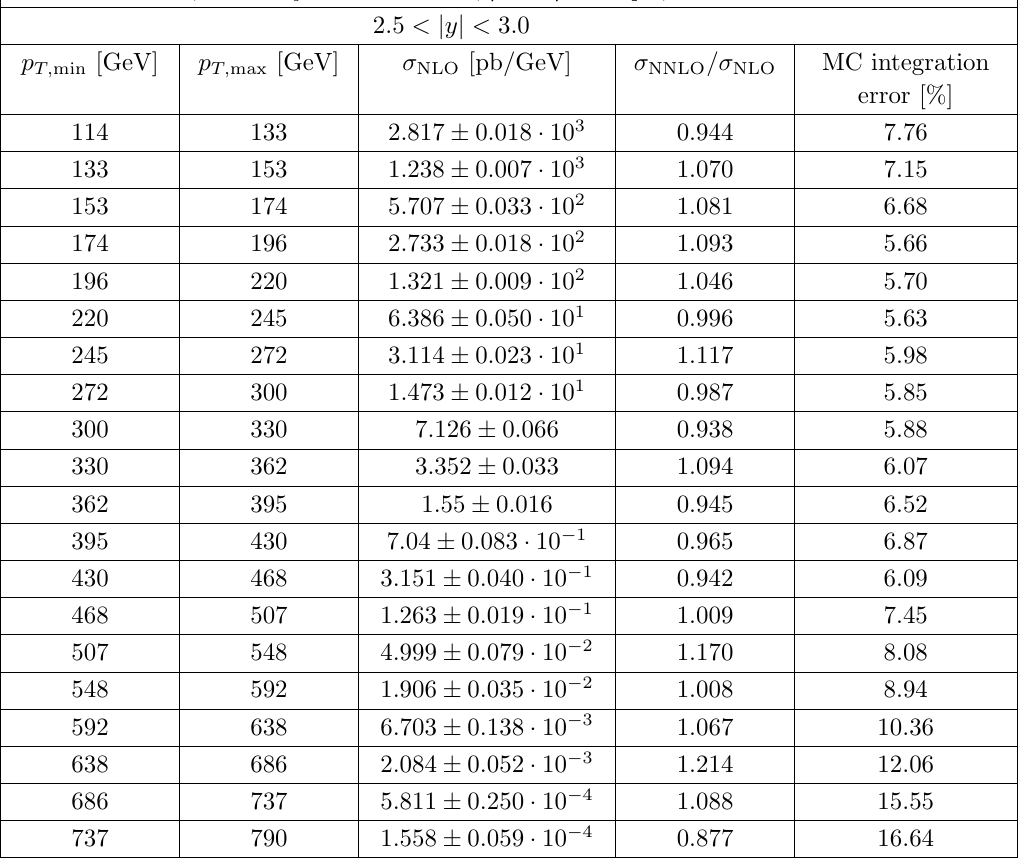
Table 6 . NLO QCD single-inclusive cross section and NNLO QCD K-factors in the rapidity slice y < 3 : 0. 2 : 5 < j j